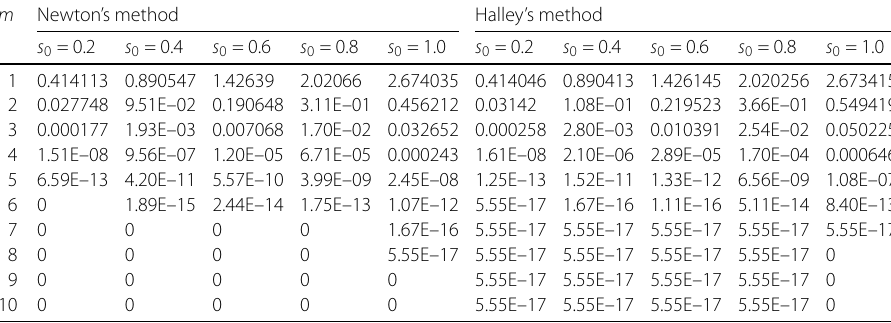
Table 4 Errors of shooting techniques |˜ F ( s m ) | in (41) versus the maximum number of iterations m for each s 0 in Example 4.2 as we set α 1 = 0.4, α 2 = 1.7, h = 0.01